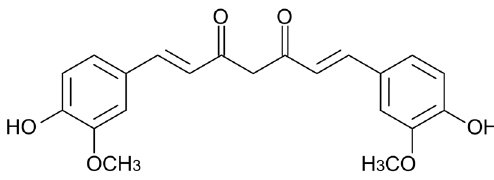
Figure 1. Chemical structure of curcumin.